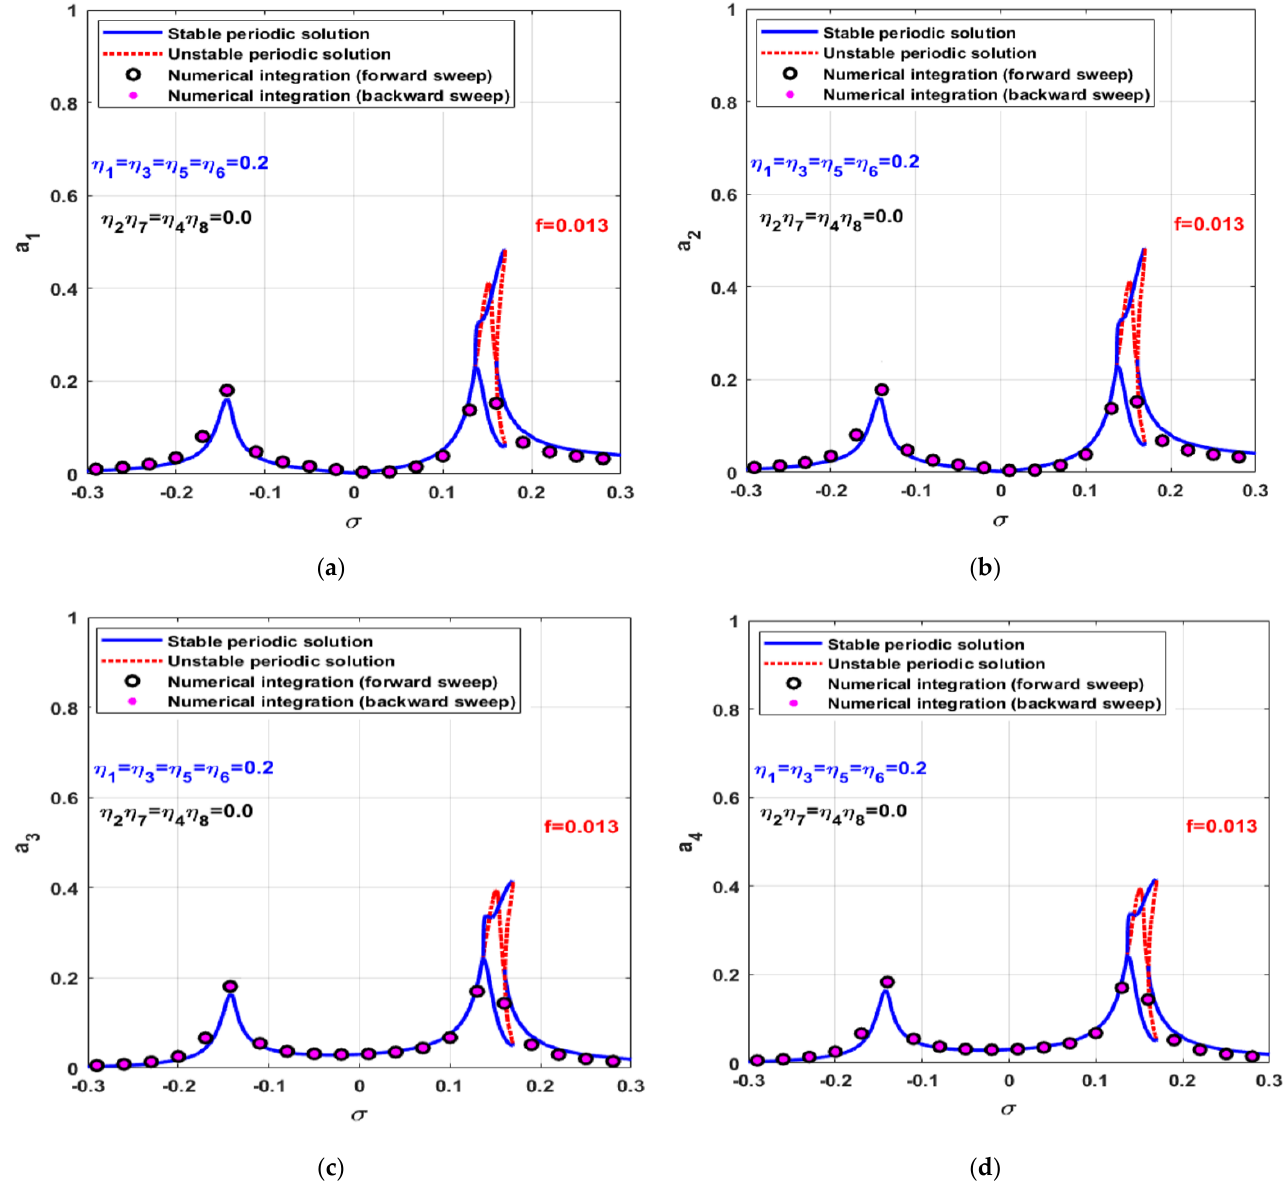
Figure 9. Vibration amplitudes of the rotor system and PPF-controller using 𝜎 as a bifurcation parameter when 𝑓 = 0.013 : ( a ) vibration amplitude in 𝑋 1 direction, ( b ) vibration amplitude in 𝑋 2 direction, and ( c , d ) vibration amplitudes of the PPF-controller.